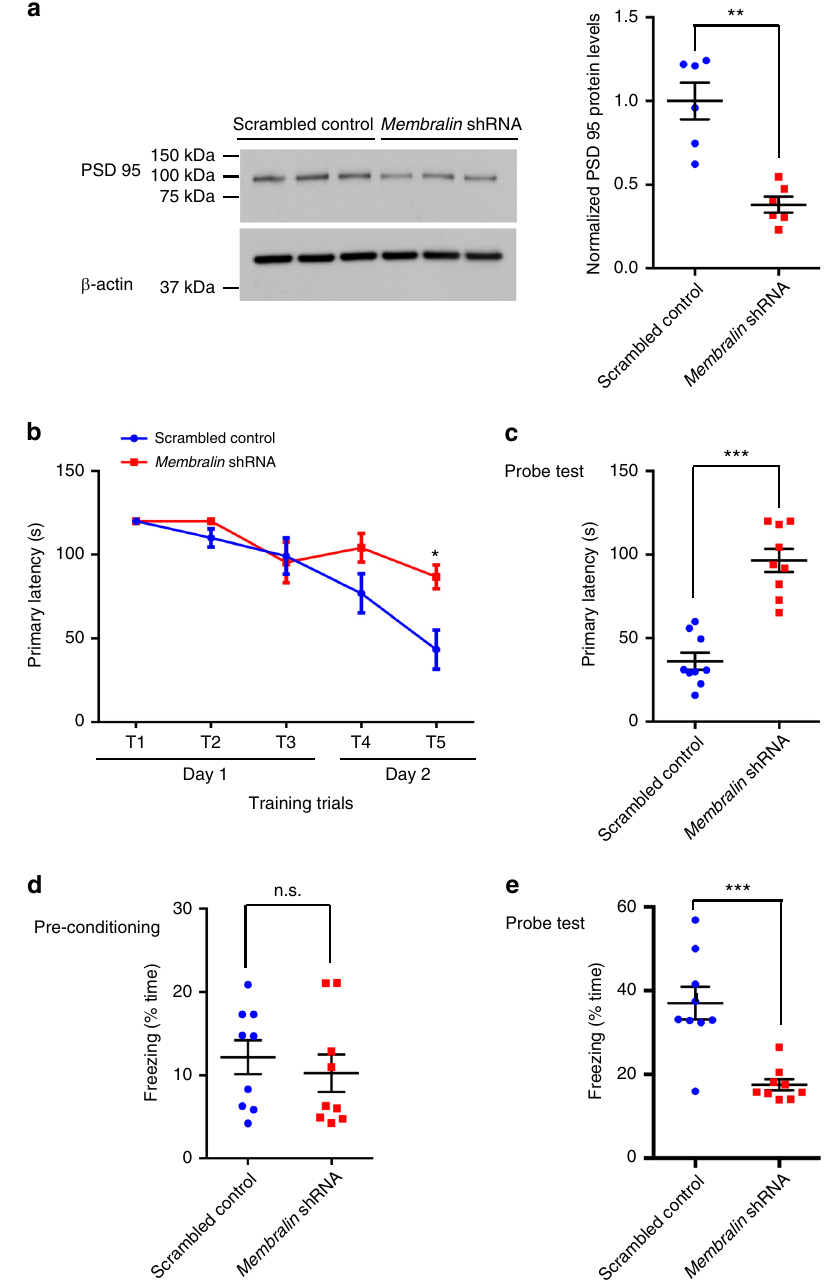
Fig. 7 AD-associated behaviors in TgCRND8 mice injected with membralin shRNA. a PSD95 levels in scrambled control or membralin shRNA-injected hippocampal tissue as determined by immunoblot, and normalized relative to β -actin ( n = 6 mice per group). b , c Barnes maze analysis: b Comparison of primary latency to target in control or membralin shRNA - injected groups in fi ve training trials ( n = 9 mice per group). c Comparison of primary latency to target in control or membralin shRNA - injected groups in probe tests ( n = 9 mice per group). d, e Fear conditioning analysis: d Comparison of freezing time (% time) in shRNA-injected experimental cohorts ( n = 9 mice per group) during the pre-conditioning trial. e Comparison of freezing time (% time) following electrical foot-shock in shRNA-injected experimental cohorts ( n = 9 mice per group) during the probe test. Data represent mean ± s.e.m. unpaired t -test, * P < 0.05, ** P < 0.01, and *** P <